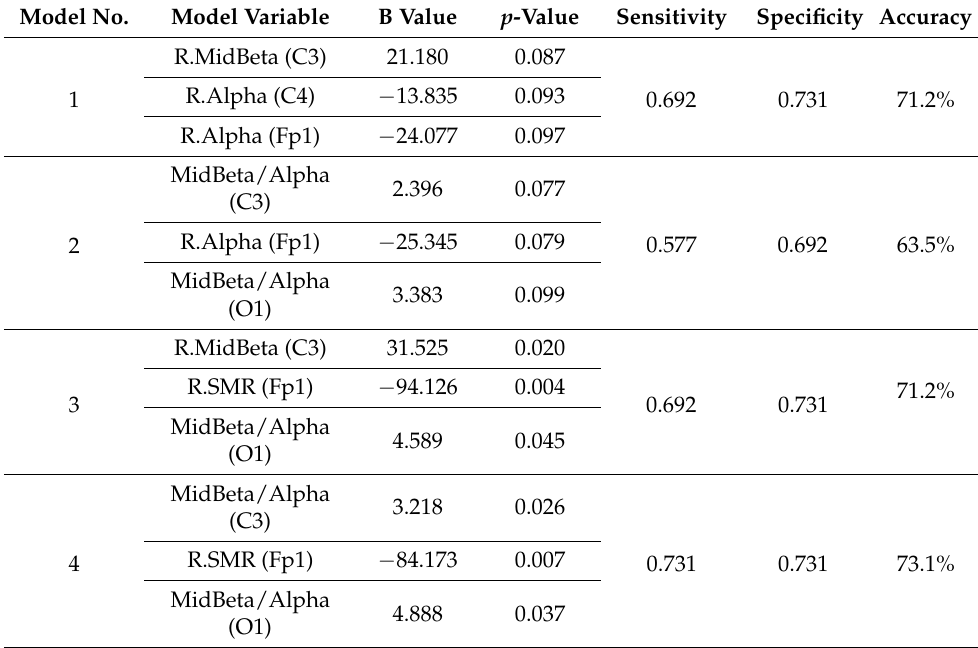
Table 7. Results of logistic regression analysis.